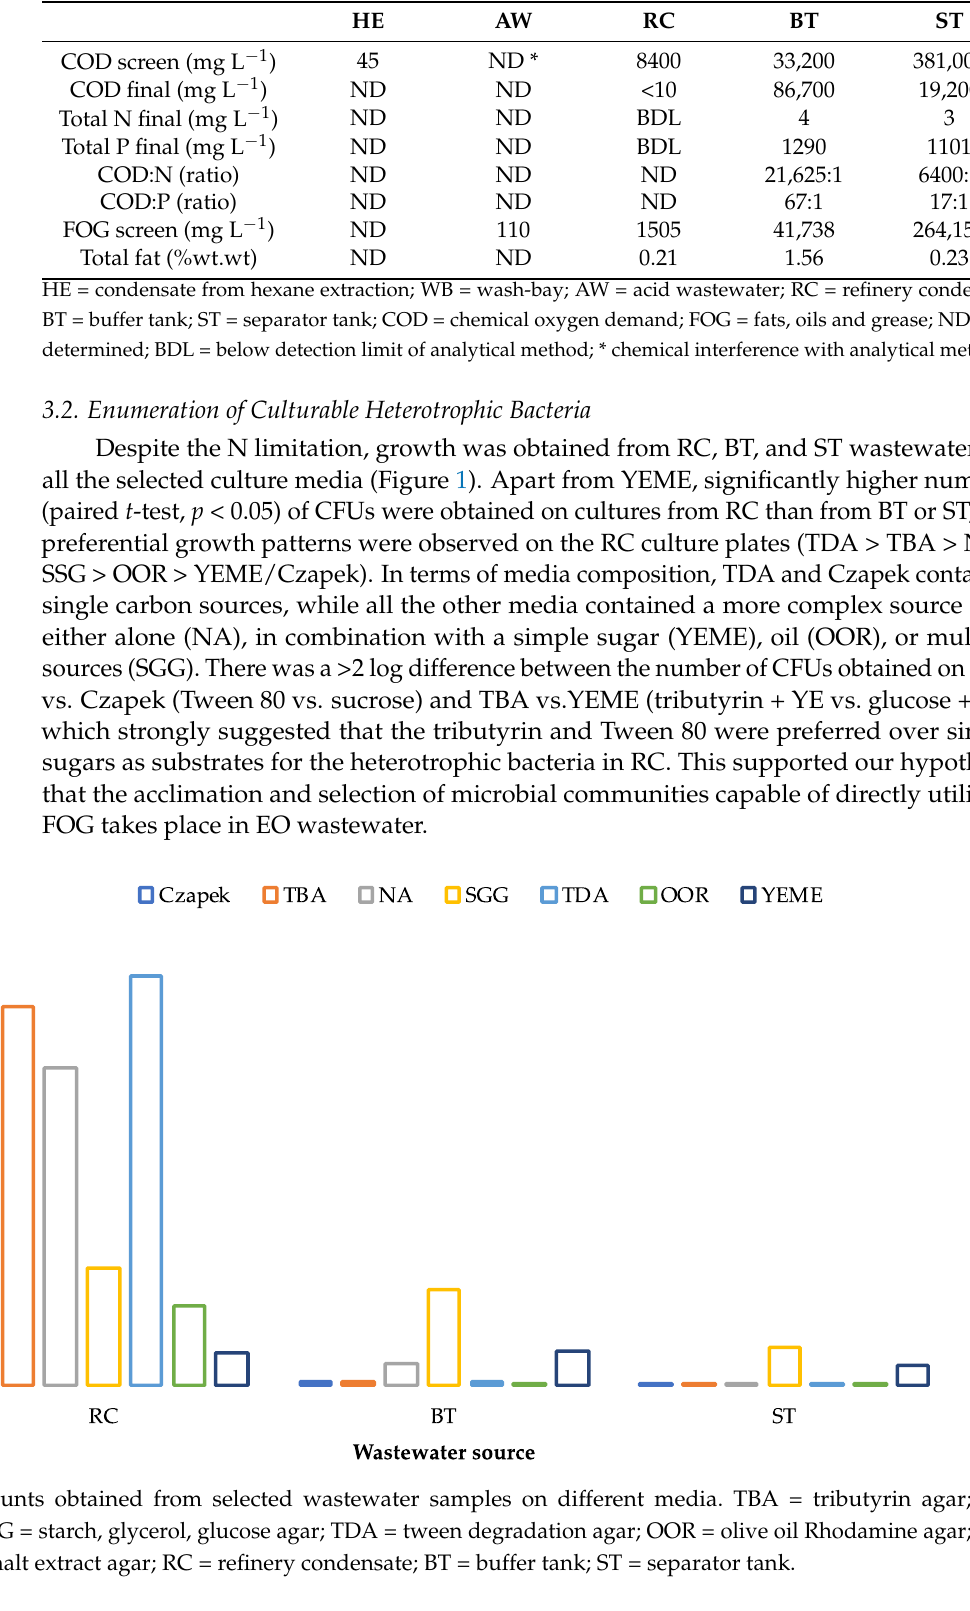
Table 1. Concentrations and ratios of major nutrients in wastewater samples.